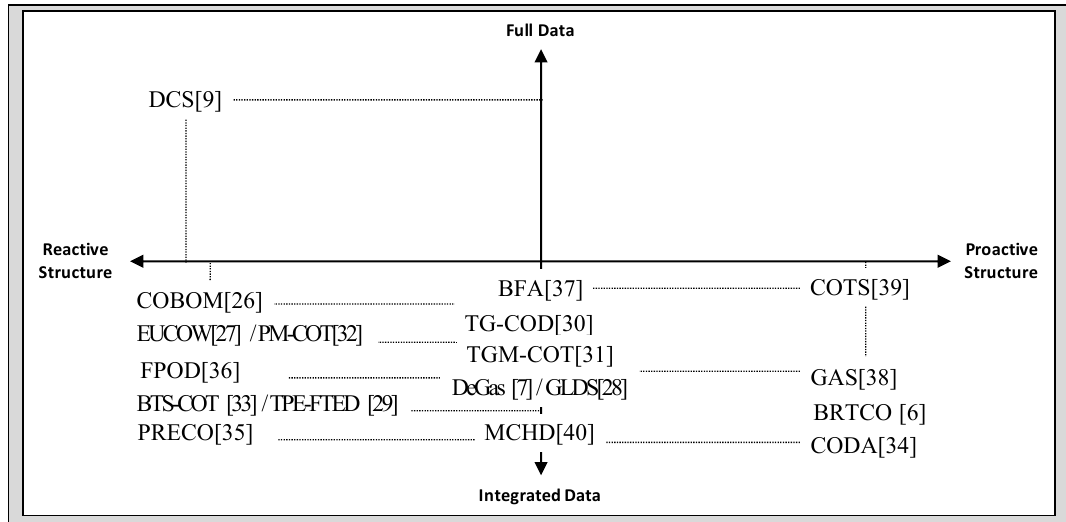
Figure 4. Comparison of technologies for integration levels, structure types, and communication overhead. Integration levels and communication overhead are represented between full data (all boundary information) and integrated